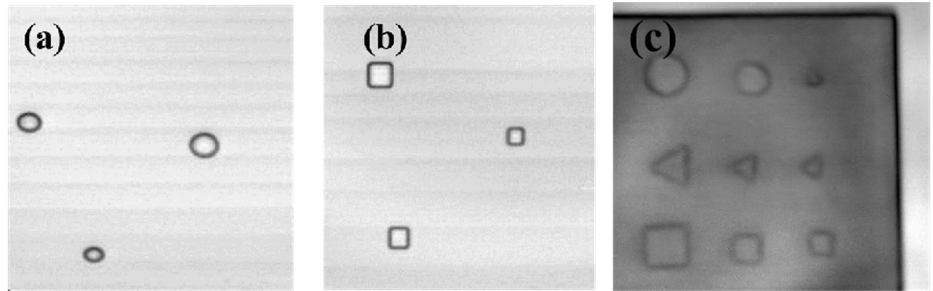
Figure 8. Defect types. (a) Terahertz image of sample A1 (b) Terahertz image of sample A2 (c) Terahertz image of test set sample